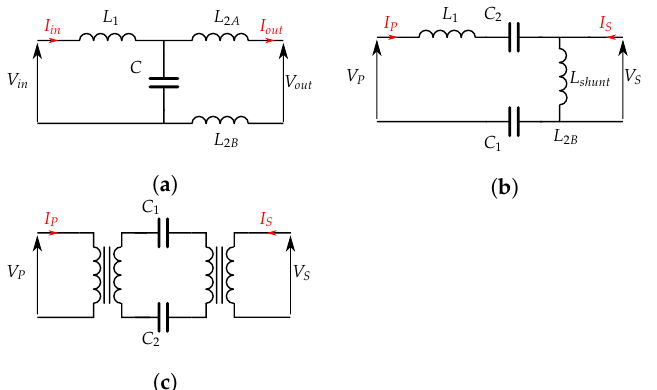
Figure 16. Some examples of other compensation topologies: ( a ) Composite LCL ( b ) Modified LLC ( c ) Transformers.